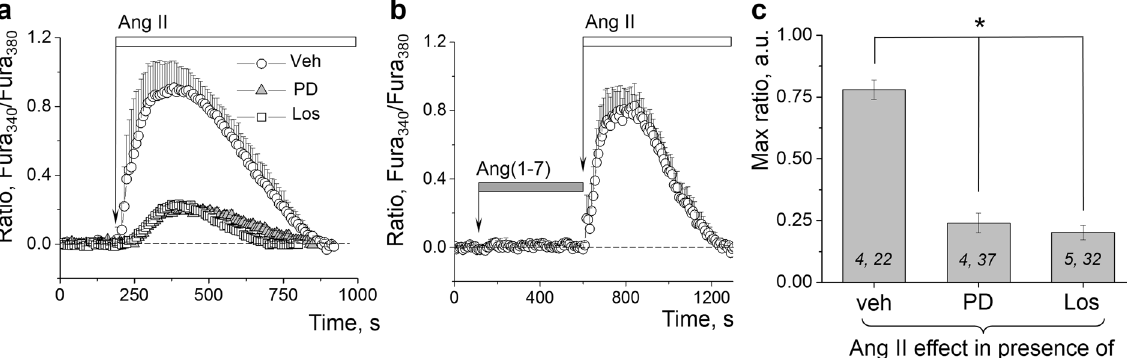
Figure 5. Ang II–dependent calcium influx in the podocytes is precluded by ATR inhibition. ( a ) Representative effects of losartan (Los, 10 µ M, 30 min incubation) or PD 123319 (PD, 1 µ M, 10 min), on Ca 2 + transients evoked in the podocytes by 10 µ M Ang II. ( b ) Illustrates the lack of an acute effect of a Mas receptor agonist Ang(1–7) on calcium influx in podocytes (concentration applied was 10 µ M). ( c ) Summarized data for the effects of Ang II on calcium influx in the podocytes in the absence or presence of losartan or PD. ( i , j ) noted on graph is number of animals ( i ) and podocytes ( j ) analyzed in each group. * P < 0.01 versus Ang II.